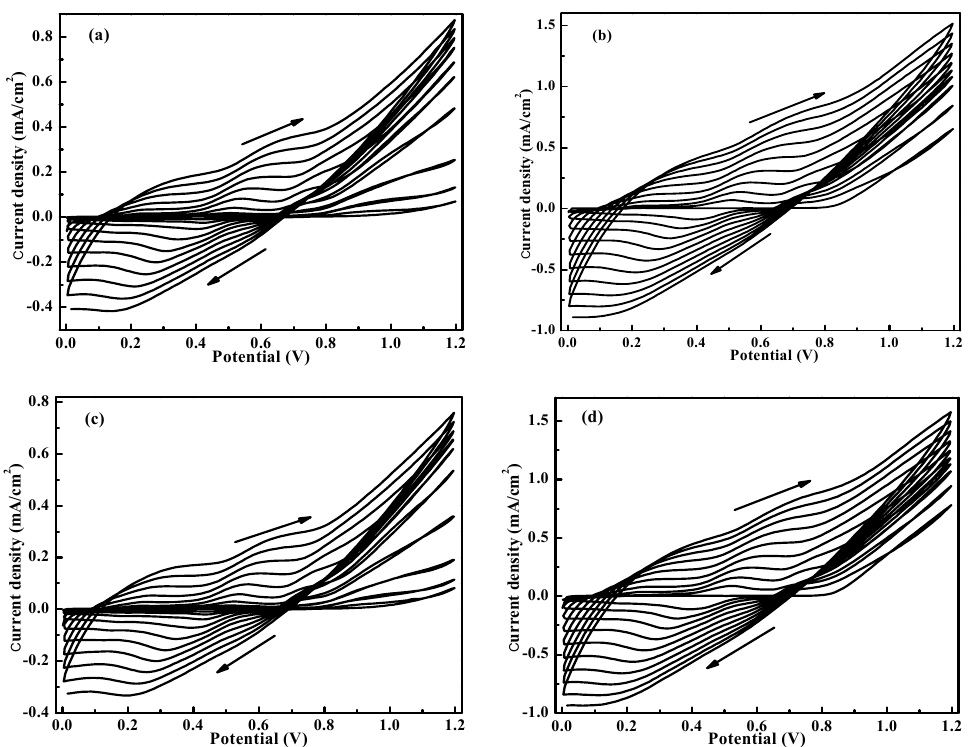
Figure 1. Electro-polymerization synthesis of polyaniline (PANI) onto ( a ) bare indium tin oxide (ITO) glass, ( b ) graphene-coated ITO glass, ( c ) WO 3 -coated ITO glass, and ( d ) double layer WO 3 / graphene-coated ITO glass at a scan rate of 50 mV / s in 0.5 M H 2 SO 4 aqueous solution containing 0.5 M